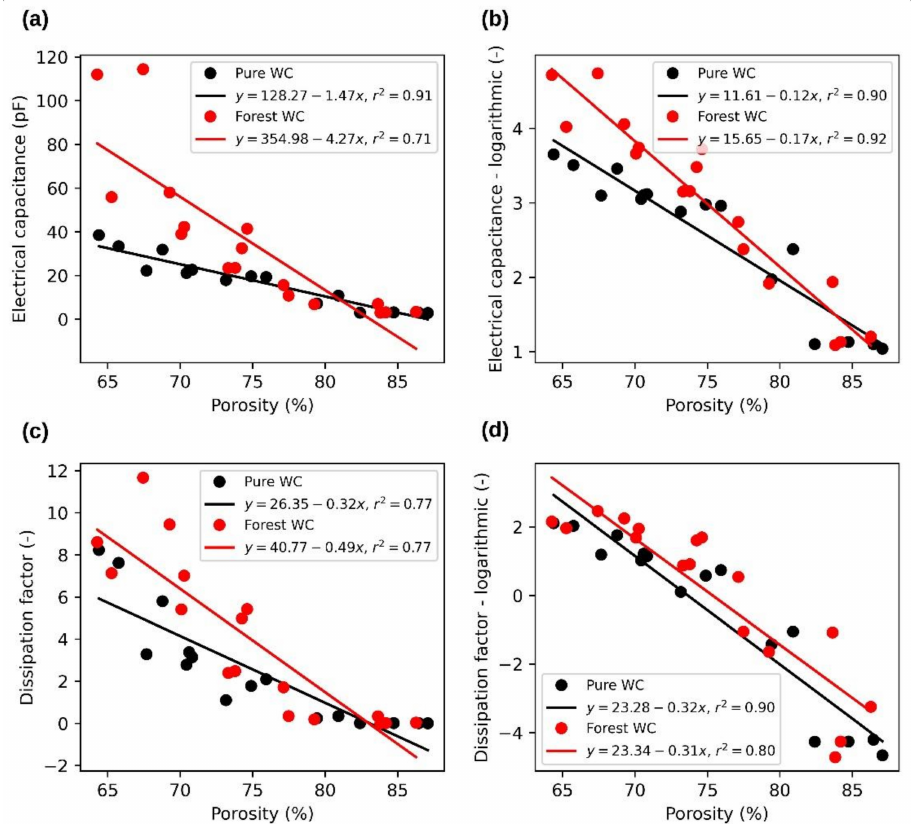
Figure 7. Relationships between wood chip porosity and dielectric properties at 100 kHz. ( a )—dependence of electrical capacitance on porosity, ( b )—dependence of logarithmic electrical capacitance on porosity, ( c )—dependence of dissipation factor on porosity, ( d )—dependence of logarithmic dissipation factor on